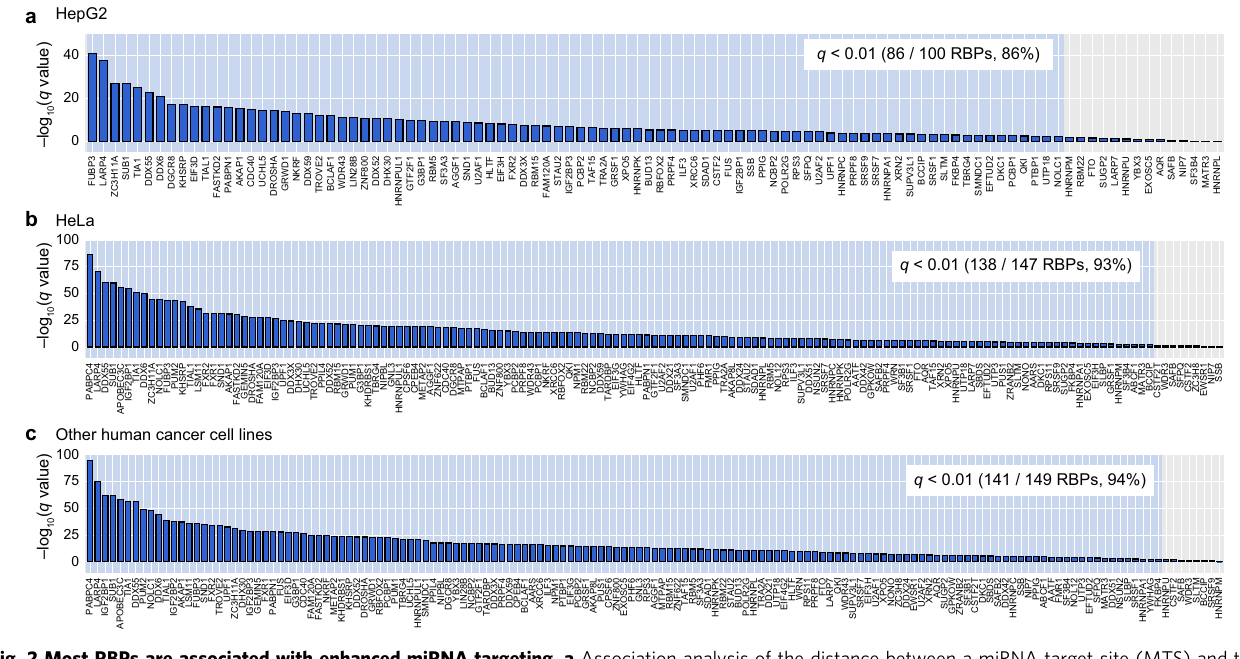
Fig. 2 Most RBPs are associated with enhanced miRNA targeting. a Association analysis of the distance between a miRNA target site (MTS) and the nearest RBP-binding site (RBS) on the 3 ′ UTR, denoted as d MTS-RBS with miRNA targeting (MT) ef fi cacy after correcting for four known confounding features (local AU content, target abundance, seed-pairing stability, and 3 ′ UTR length) for individual RBPs. For each of the 100 RBPs whose RBSs in HepG2 cell line were identi fi ed in the ENCODE eCLIP-seq dataset, the association between d MTS-RBS and MT ef fi cacy was tested after correcting for the four known confounding features for MT by the multiple linear regression (two-sided t -test). The y -axis represents the statistical signi fi cance of the observed association: upward and downward directions indicate the MT enhancement ( − log 10 ( q value)) and the MT suppression (log 10 ( q value)) by the RBP, respectively. The number of RBPs that exhibits a signi fi cant association between d MTS-RBS and MT ef fi cacy after multiple test correction by the false discovery rate is shown on top. b , c Association analysis between d MTS-RBS and MT ef fi cacy by using 59 microarrays that measured the whole- transcriptome response to ectopically introduced miRNAs or siRNAs into HeLa cell line ( b ), and for 75 microarrays that measured the whole-transcriptome response to ectopically introduced miRNAs into various human cancer cell lines ( c ). Otherwise as in ( a